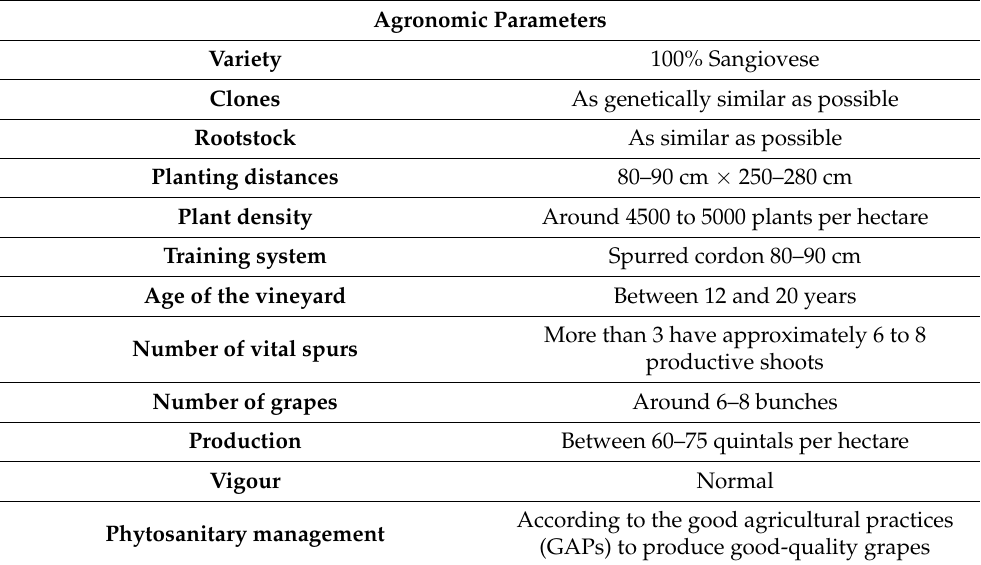
Table 1. Agronomic parameters of the chosen vineyards.